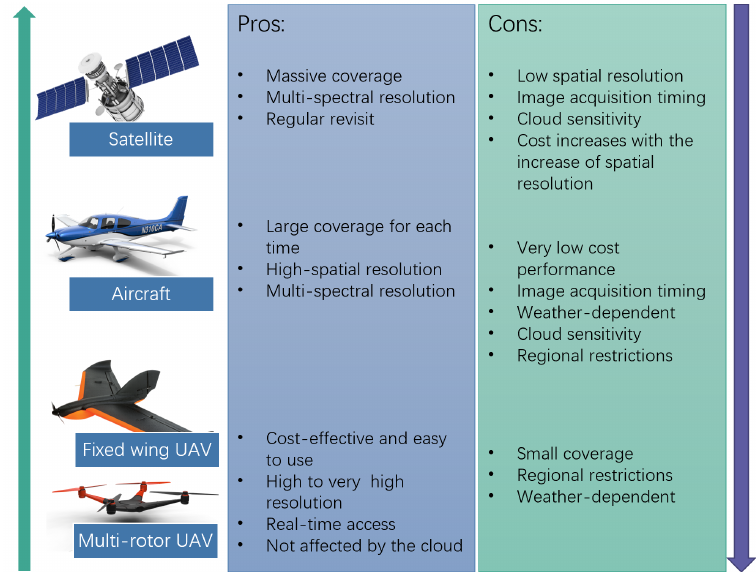
Figure 1. Pros and cons of the existing remote-sensing